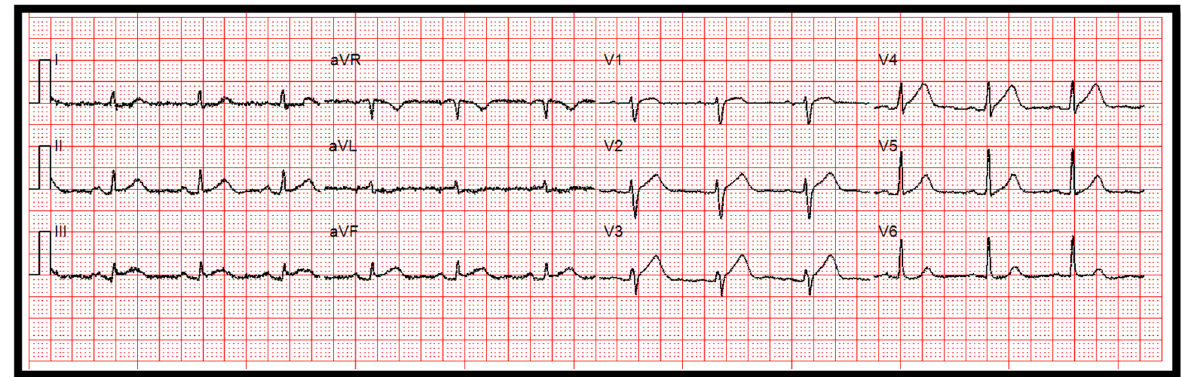
Fig. 6 ECG on arrival to hospital—Courtesy Dr Riley Batchelor (RMH)